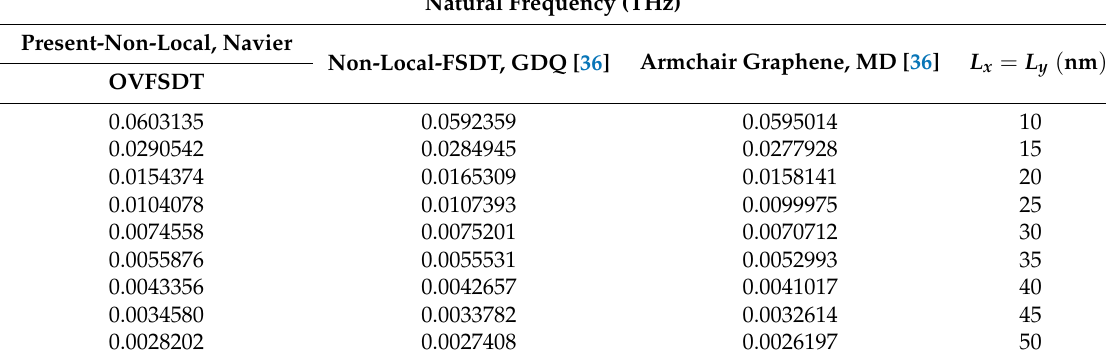
Table 2. Numerical results based on the OVFSDT, molecular dynamics, and non-local FSDT. E = 1 TPa, υ = 0.16, h = 0.34 nm, µ = 1.34 nm 2 .